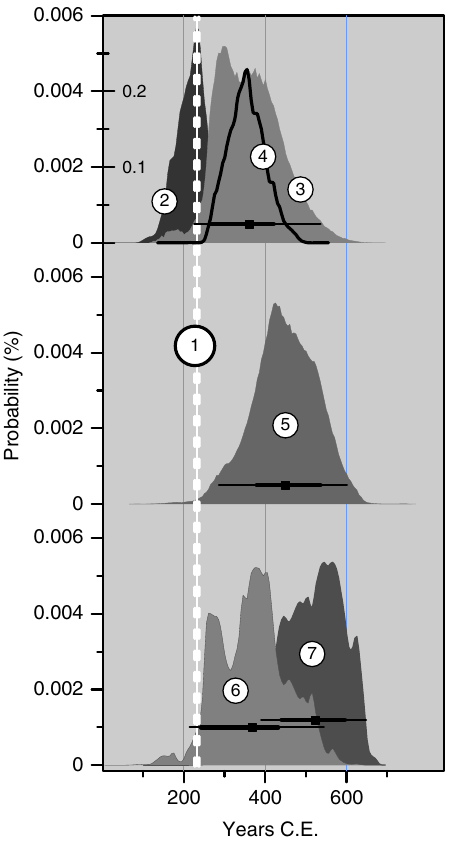
Fig. 4 Dates for the Taupo eruption from a stratigraphic sequence outside the in fl uence of Taupo Volcanic Zone groundwater. All dates place the Taupo eruption signi fi cantly later than 232 CE. 1 , present date for Taupo (broken line thickness, 1 s.d.); 2 , probability distribution for 25 wiggle match calibrated radiocarbon ages, combined as described in Methods; 3 , probability distribution for boundary between 8 pre- and 2 post-Taupo ages on samples from stratigraphic sequence across the Taupo ignimbrite at Hukanui, inland Hawkes Bay, North Island, New Zealand 55 ; symbol and horizontal lines, mean, thick line 1 σ , thin line 2 σ ; 4 , probability distribution for the second wiggle match ages with 5% old carbon removed; 5 , boundary between ages on carbonized leaf within the Taupo ignimbrite and Gallirallus australis tibiotarsus on surface of ignimbrite (symbol and horizontal lines, mean, 1 s.d., 2 s.d.). 6 , 7 probability distributions for leaf and tibiotarsus, respectively (symbol and horizontal lines, mean, thick line 1 s.d., thin line 2